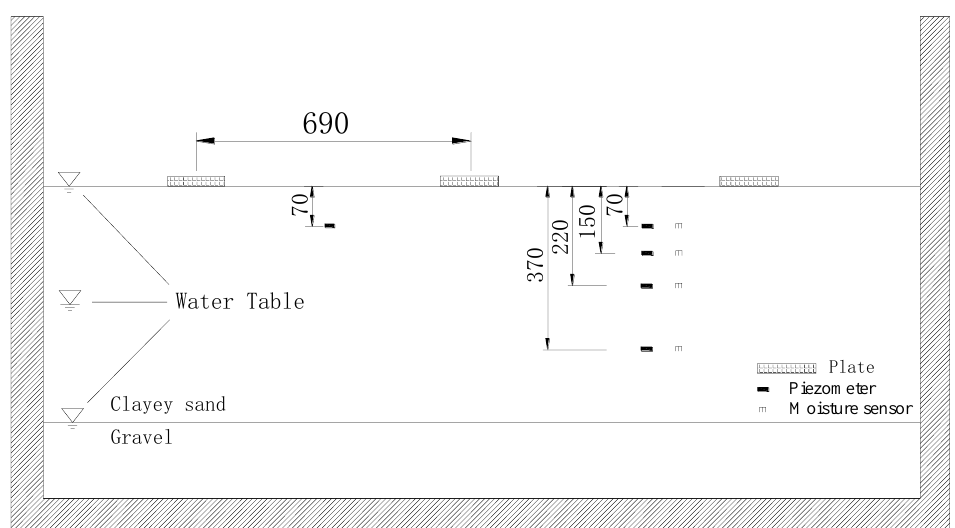
Figure 5. Different depths of water table and the arrangement of sensors.